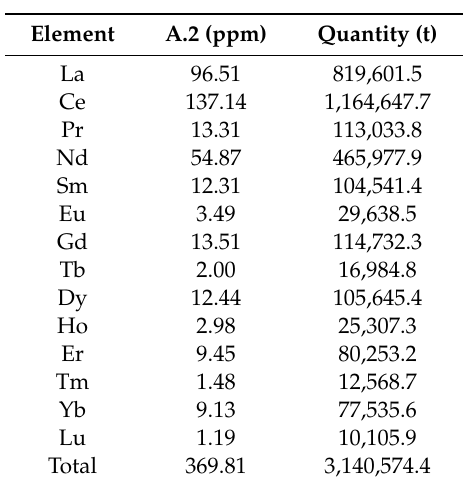
Table 10. Calculation of the amount of REEs contained in roasting and magnetic separation